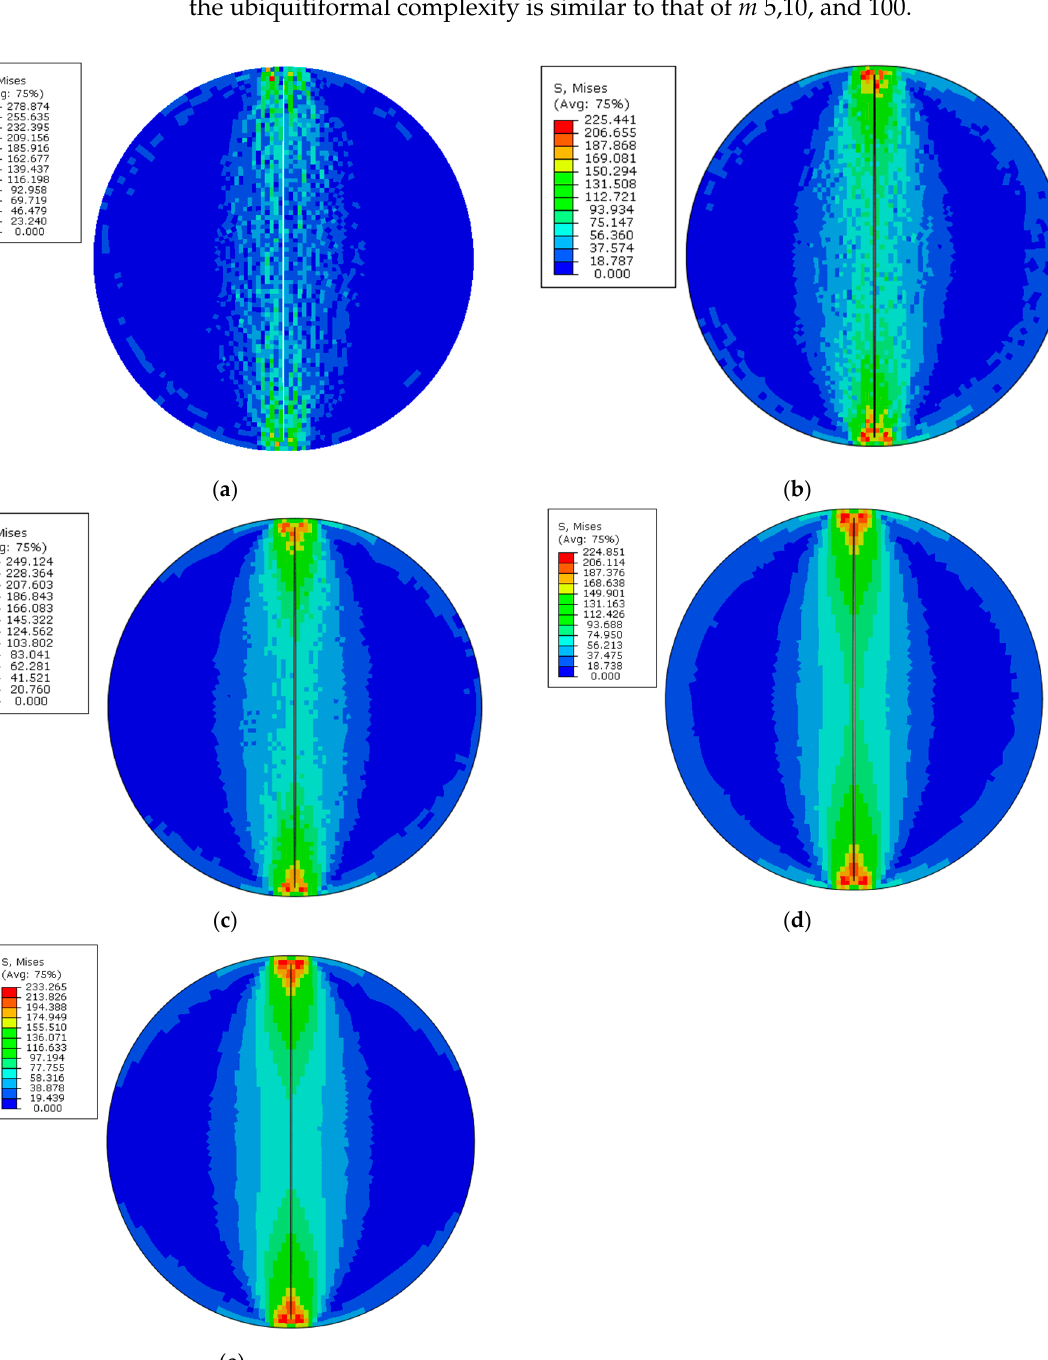
Figure 14. Relationship of D and Brazilian strength and m . The stress–displacement curves of the rock specimens with different homogeneities are shown in Figure 15. The rock specimens with 1.5 ≤ m ≤ 100 under Brazilian splitting load all underwent the three stages of linear elasticity, yielding, and post-peak. The dif- ference among all the stress–displacement curves is that their yielding phase becomes shorter with the increase in homogeneity. When 5 ≤ m ≤ 100, the stress–displacement curves almost coincided. When m is greater than 1000, the yield phase is almost unrecog- nizable, and the rock sample breaks directly after the linear elastic phase. Regardless of the homogeneity of the rock, brittle damage is evident under Brazilian splitting loads.